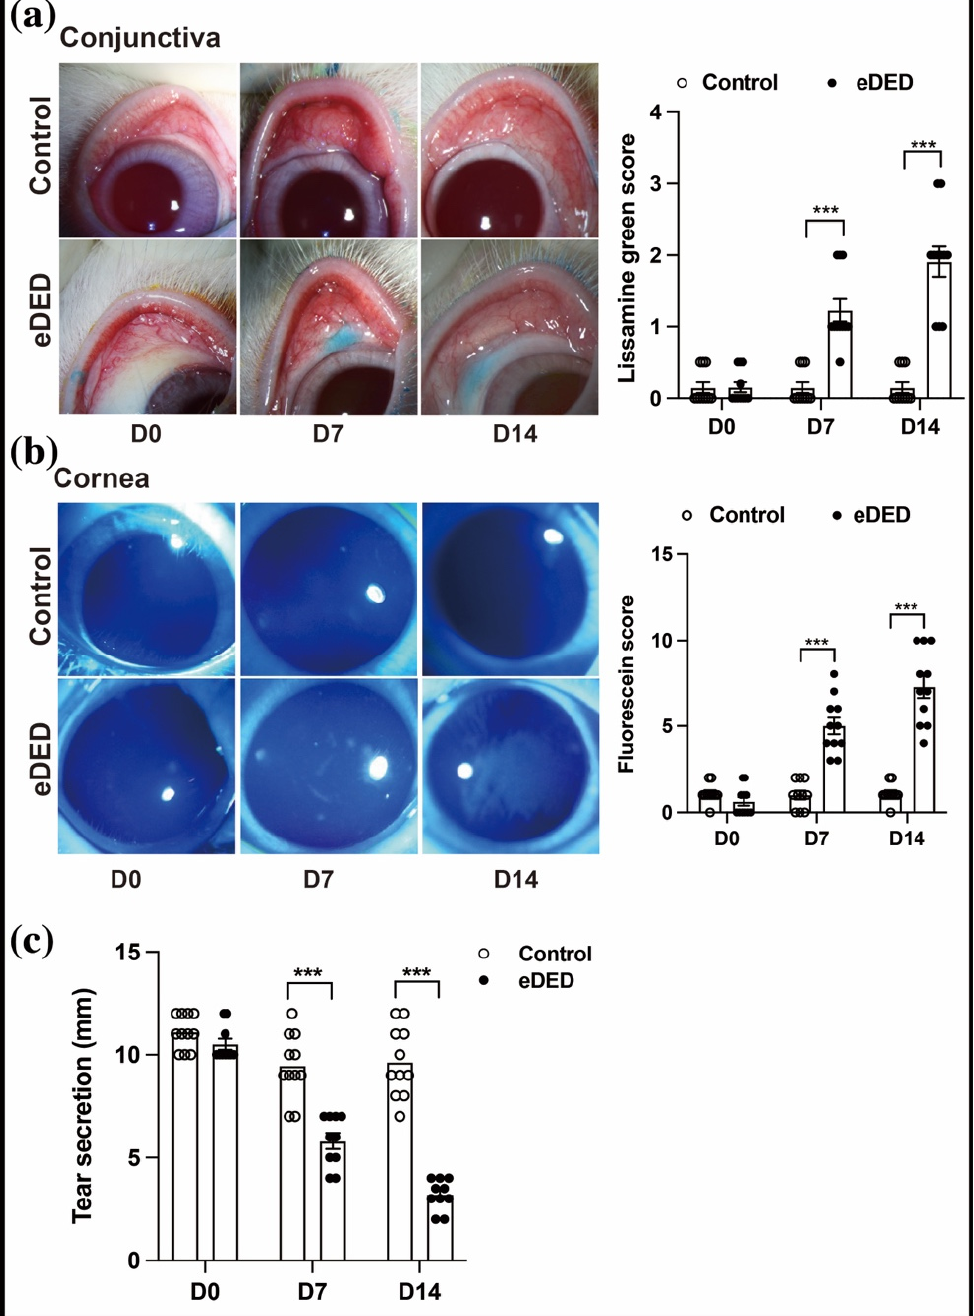
Figure 1. Ocular surface injury and tear secretion decreased in eDED. ( a ) Left, representative images of conjunctiva lissamine green staining in the control and eDED groups. Right, bar graph showing the score of conjunctiva lissamine green in the control (n = 10) and eDED groups (n = 11). ( b ) Left, representative images of corneal fluorescein staining in the control and eDED groups. Right, bar graph showing the score of cornea fluorescein in the control (n = 10) and eDED groups (n = 11). ( c ) Bar graph showing the tear volume in the control (n = 11) and eDED groups (n = 10). Data are represented as mean ± SEM. *** p < 0.001.